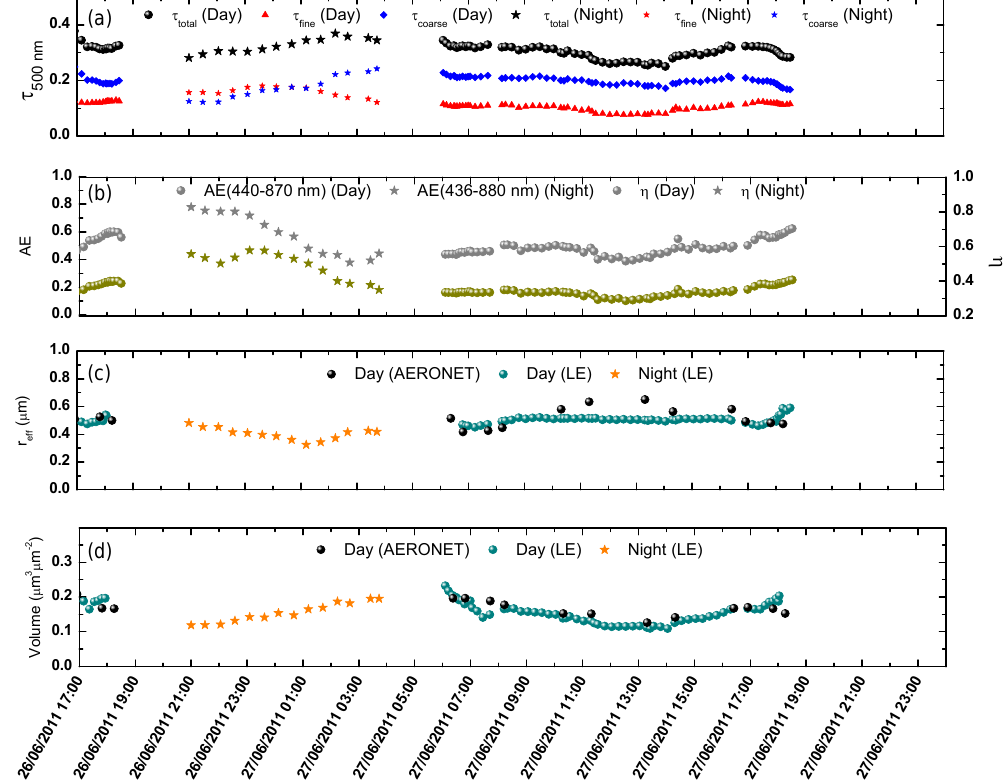
Figure 2. Night-to-day temporal evolution of (a) aerosol optical depth ( τ λ ) including also its separation between fine ( τ fine ) and coarse ( τ coarse ) mode at 500nm, (b) Ångström exponent (AE) between 440 and 870nm (436–880nm for star photometry) and fine mode fraction η (c) effective radius ( r eff ) and (d) column-integrated volume concentration (V) on 27 June